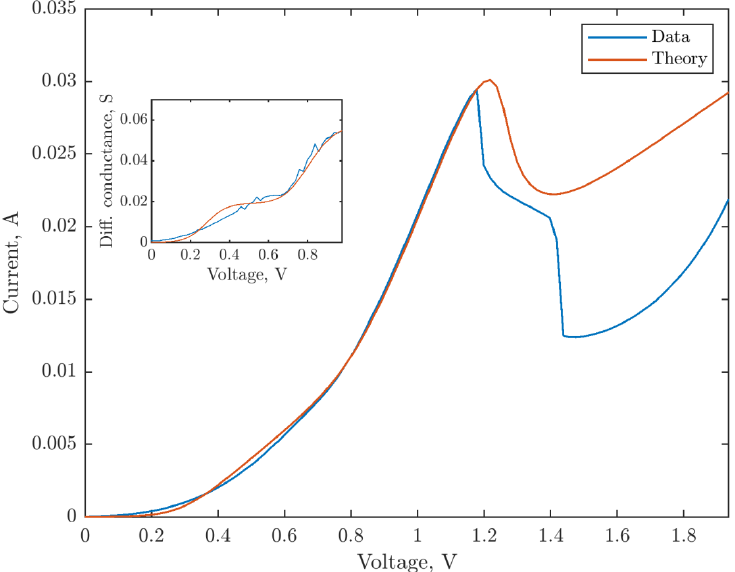
Figure 3. Experimental current – voltage characteristics of RTD No. 1 in comparison with use of the compact model.